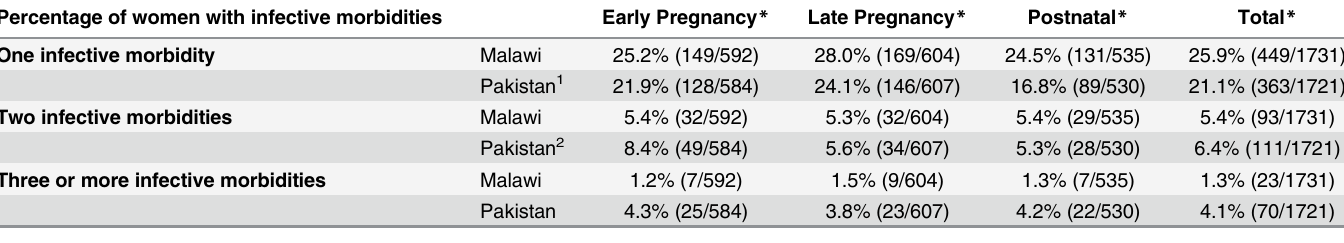
Table 4. Burden of infective morbidity among pregnant and postnatal women in Malawi and